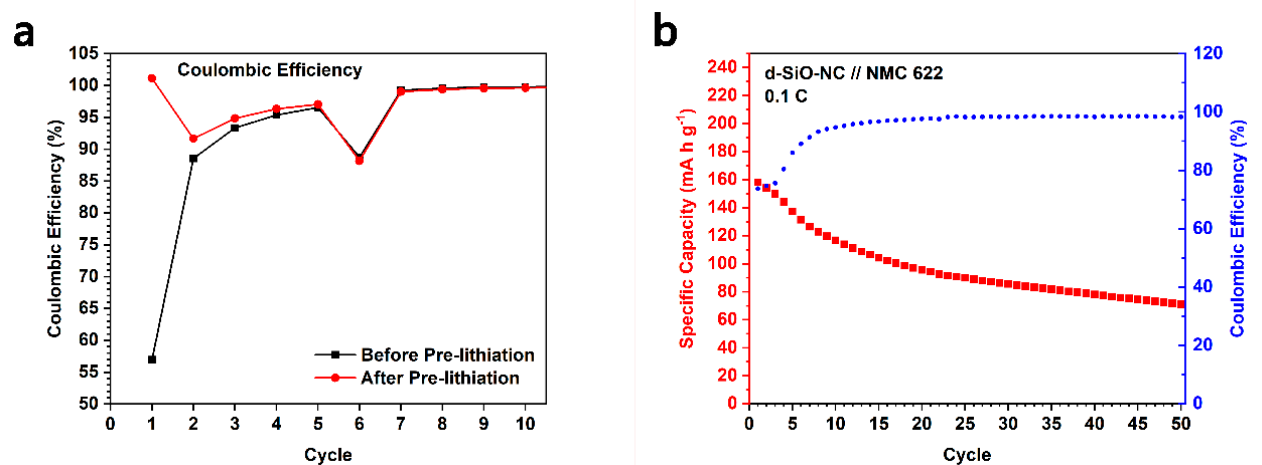
Figure 10. ( a ) Coulombic efficiency of first several cycles in cycling test of d-SiO-NC (2:1.5:3) before and after pre-lithiation. ( b ) Cycling performance of full cell fabricated by pre-lithiated d-SiO-NC (2:1.5:3) and LiNi 0.6 Mn 0.2 Co 0.2 O 2 (NMC 622).